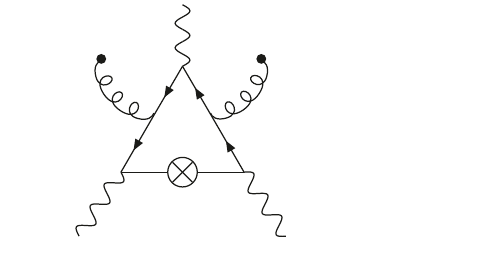
Figure 6 . Contributions from four-quark operators obtained cutting two quark lines. All possible ways to connect the gluon to the quark lines must be considered.